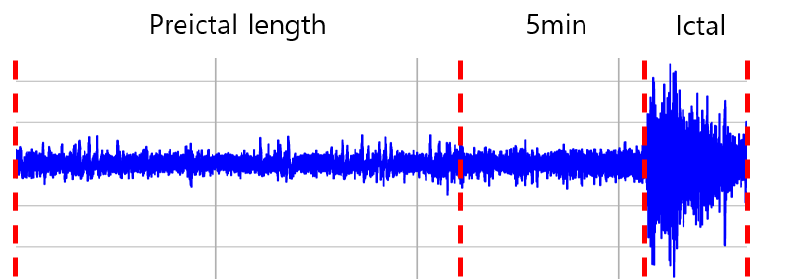
Figure 3. Preictal